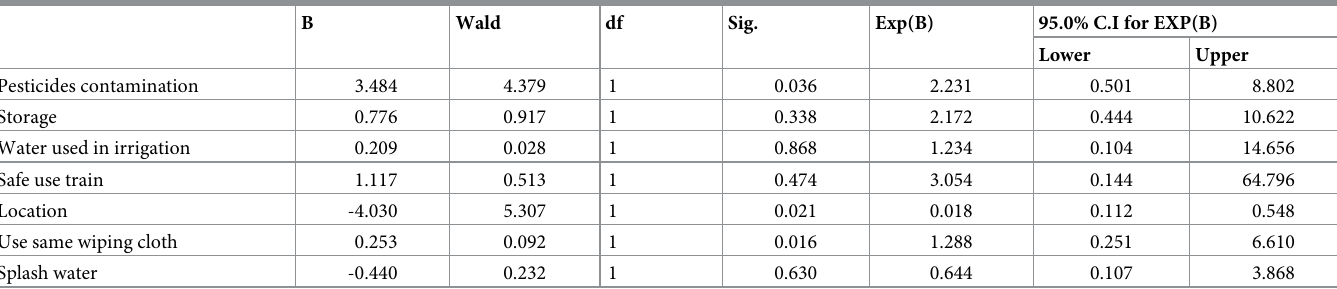
Table 9. Binary logistic regression of factors associated with pesticides and bacterial contamination of fresh vegetables locally produced and consumed.